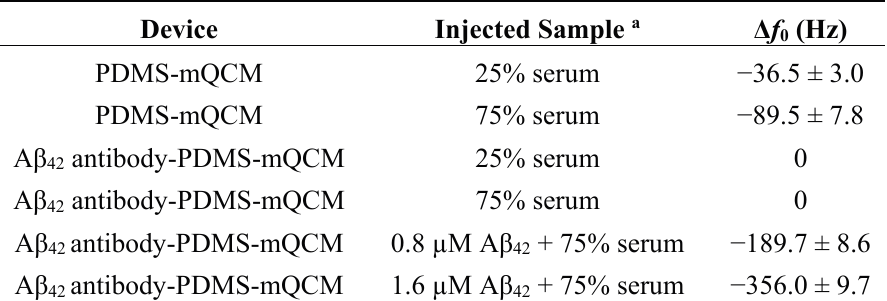
Table 2. Non-specific binding determination for different